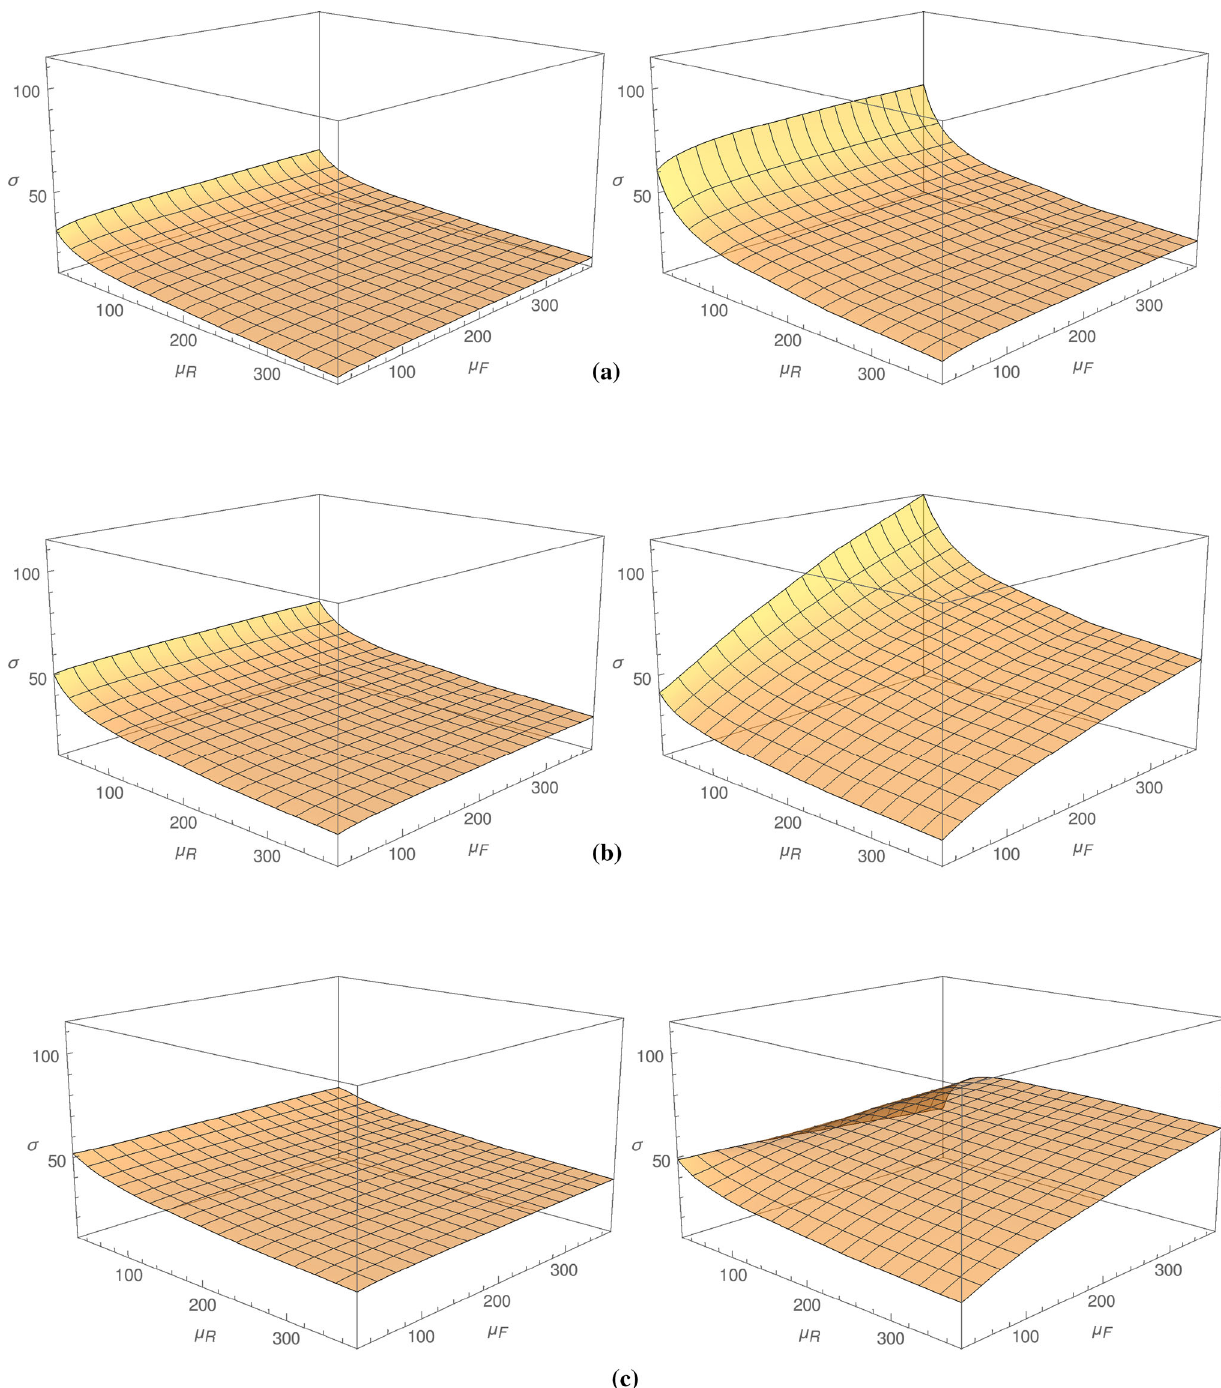
Fig. 1 The cross section σ in picobarns[pb] w.r.t μ R and μ F for fixed order(left panel) vs resumed prediction(right panel) at a LO vs LO + LL